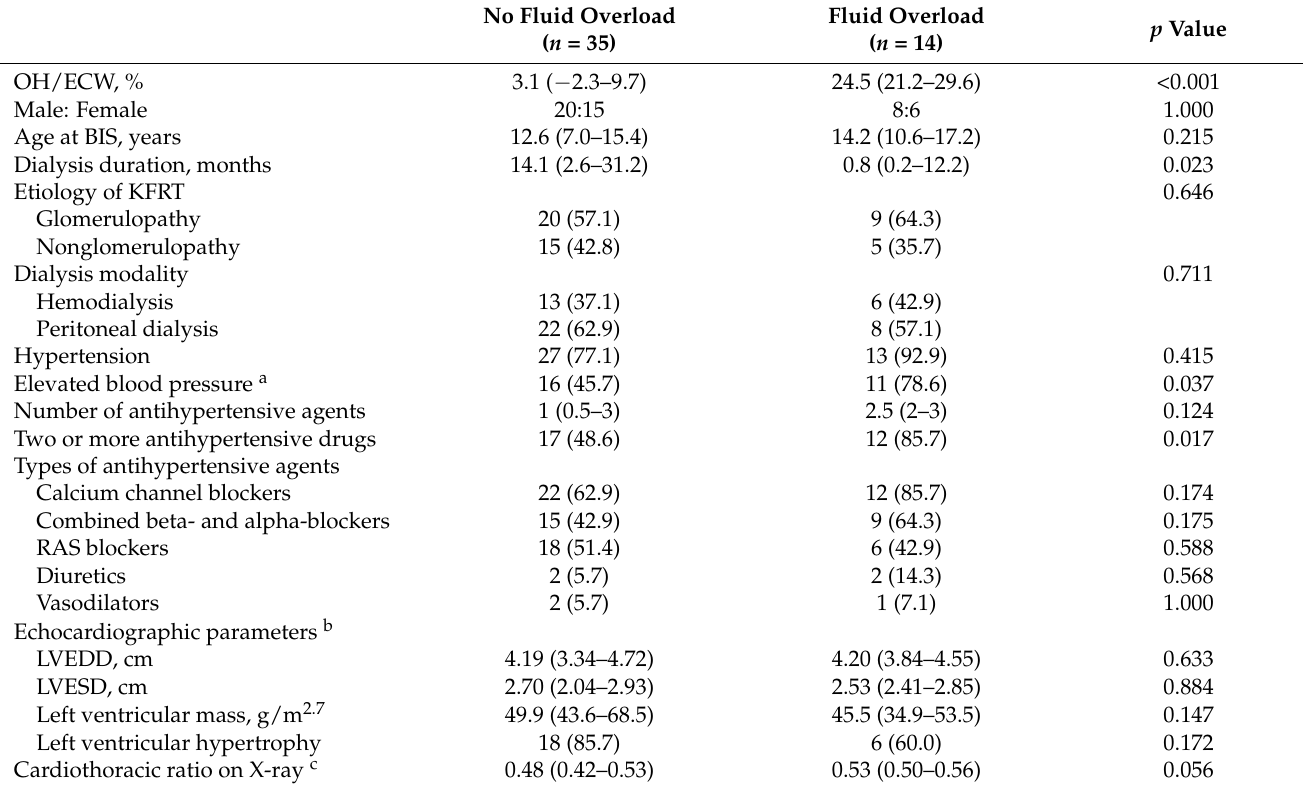
Table 1. Fluid overload status of bioimpedance spectroscopy and its relevance with clinical characteristics.